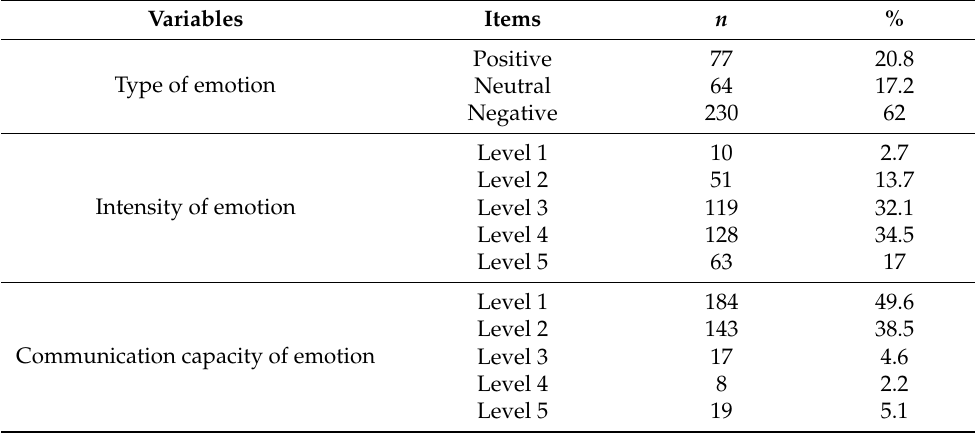
Table 2. Descriptive statistical analysis results ( n =